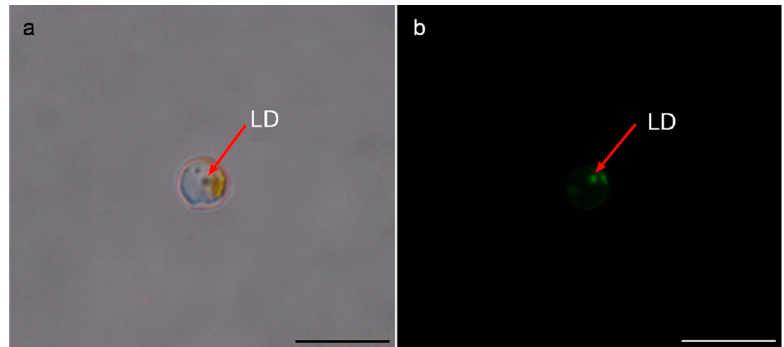
Figure 2. Lipid-enriched droplets (Ld) in the RSCs of A. anophagefferens strain CCMP1984 as indicated by the arrows. The RSCs of A. anophagefferens shown in ( a ) were observed under bright field microscopy, while ( b ) shows the same cell, but it was observed under epi-fluorescence microscopy (filters settings BP450 ‒ 480 nm for excitation and BA > 515 nm for emission), as it was stained by BODIPY 505/515. Scale bars = 10 μ m.